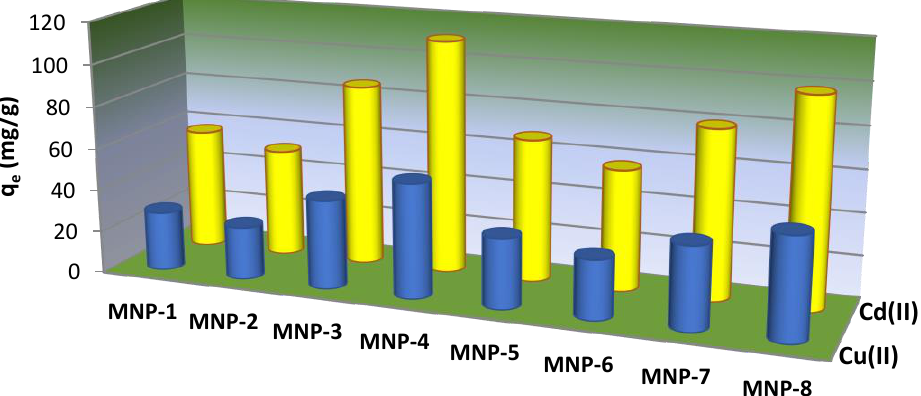
Figure 11. Comparison of the adsorption activity of the MNP samples during the adsorption of the studied cations from individual component solutions at pH 6.7.